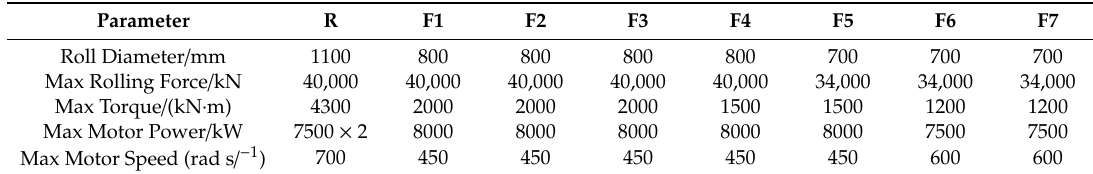
Table 1. Main plant parameters of hot tandem production line.